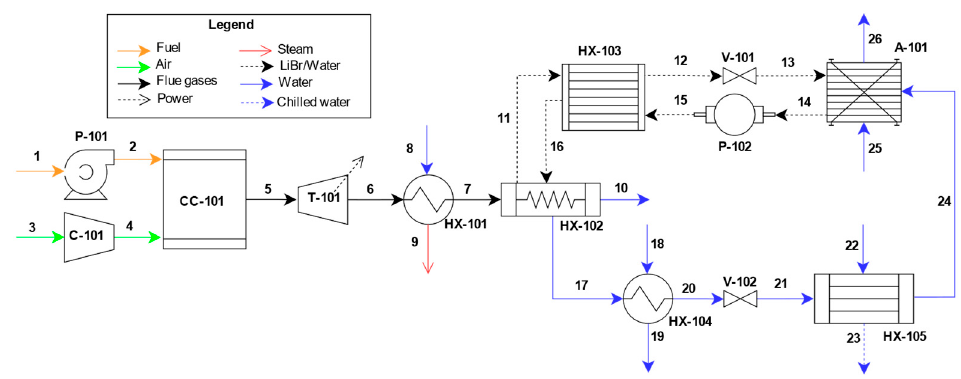
Figure 2. CCHP system based on biofuel from SCGs.